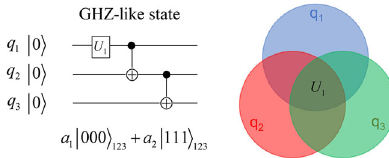
Fig. 3 The dependence picture of the GHZ-like state. The fi gure shows the creation circuit of the GHZ-like state and the Venn diagram of the unitary dependence picture. U 1 ¼ U 1 ð a 1 ; a 2 ; α Þ ¼ ð applied to q 1 . When the parameters satisfy a 1 ¼ a 2 ¼ 1 ffiffi the GHZ state.